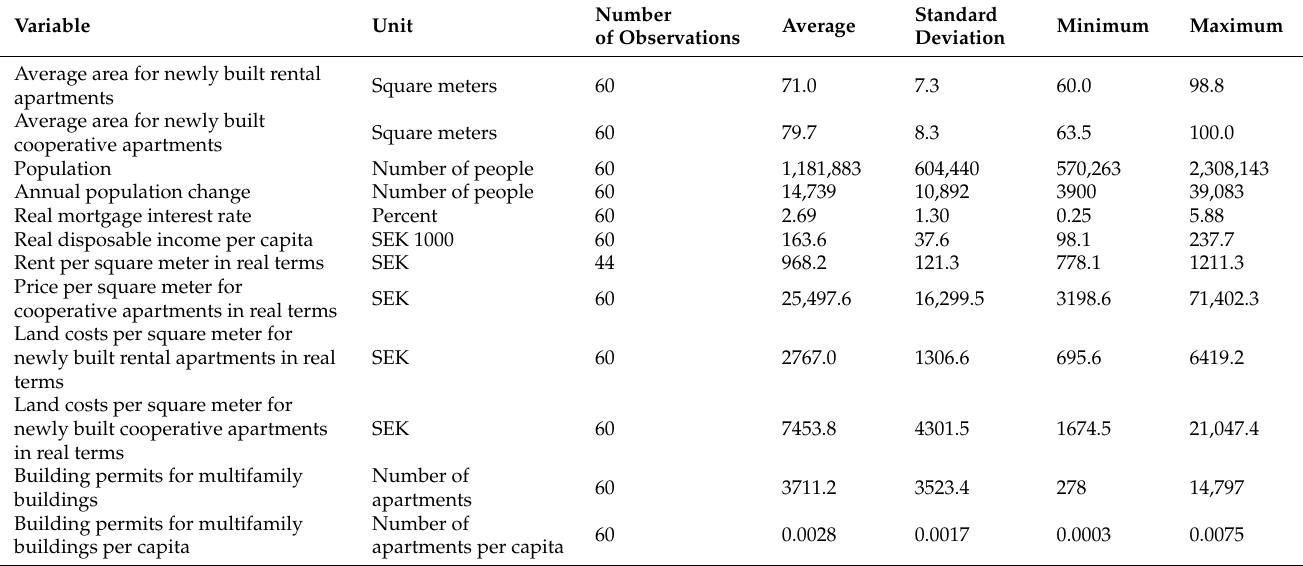
Table 2. Summary